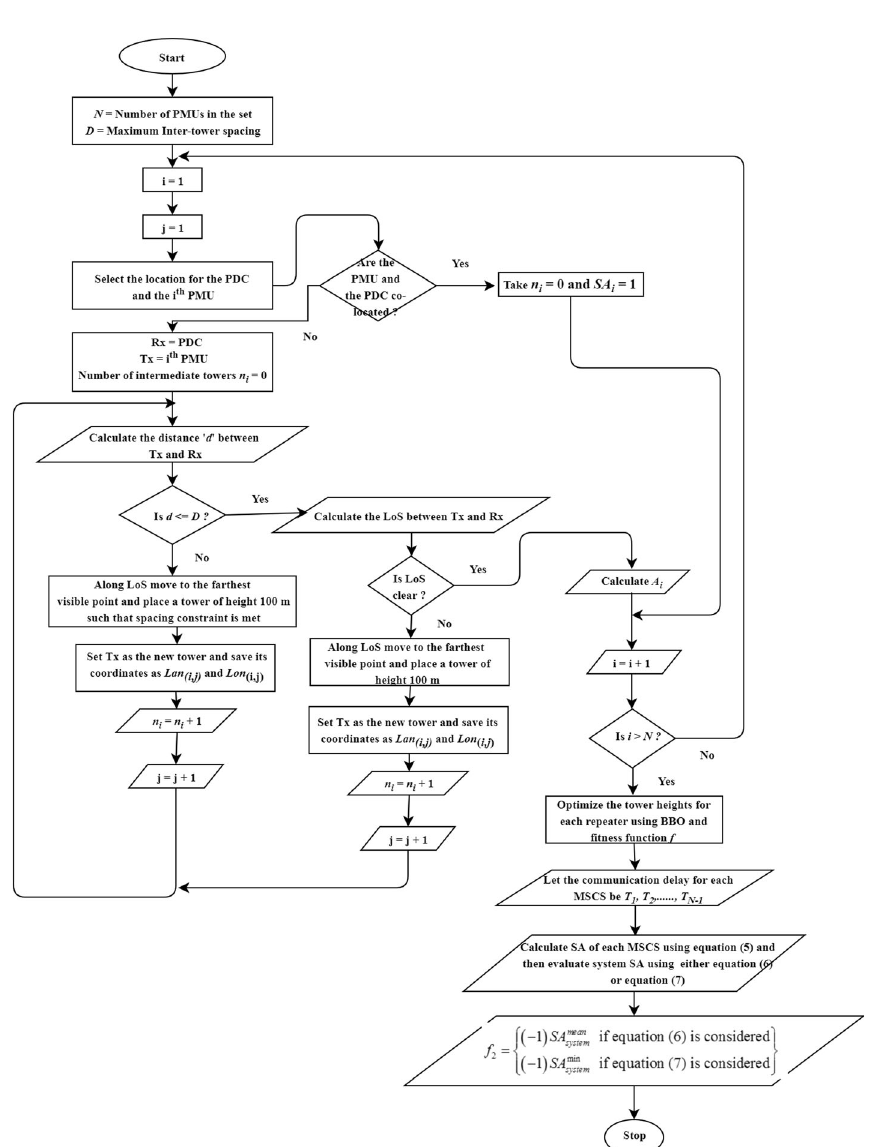
Fig. 6 Flow chart for SA